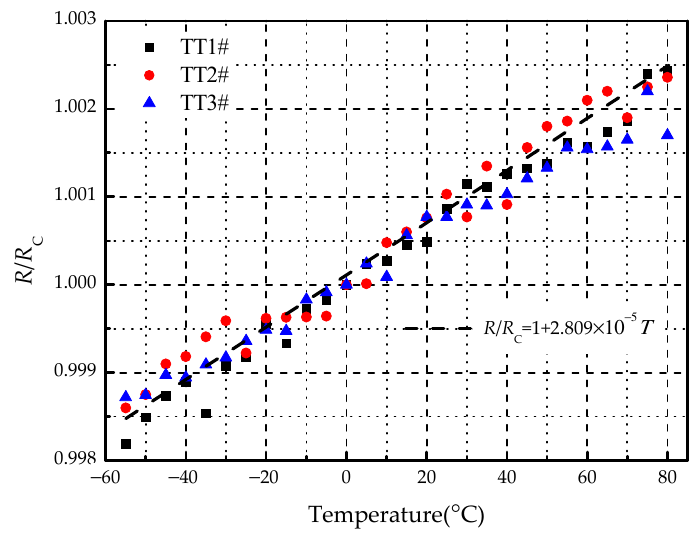
Figure 8. Variation of R / R C along with temperature.